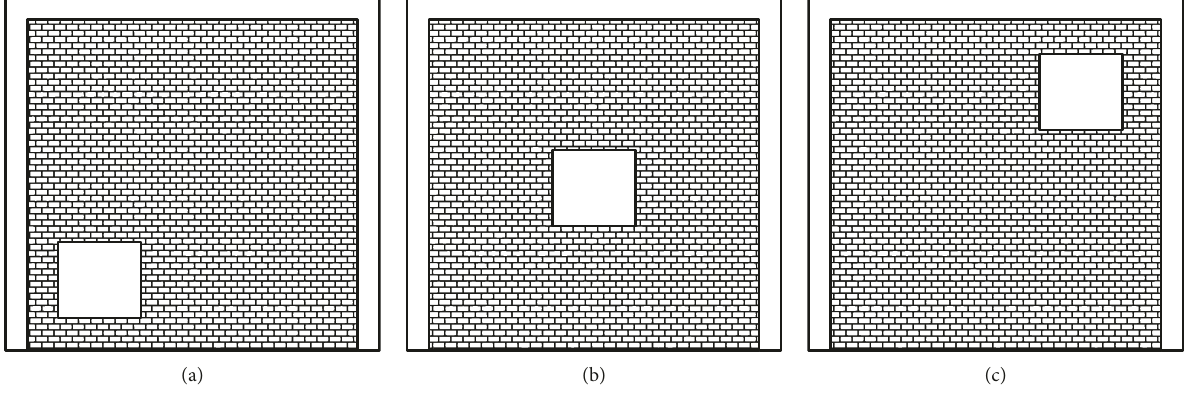
Figure 10: Opening positions. (a) Case A, (b) Case B, (c) Case C.